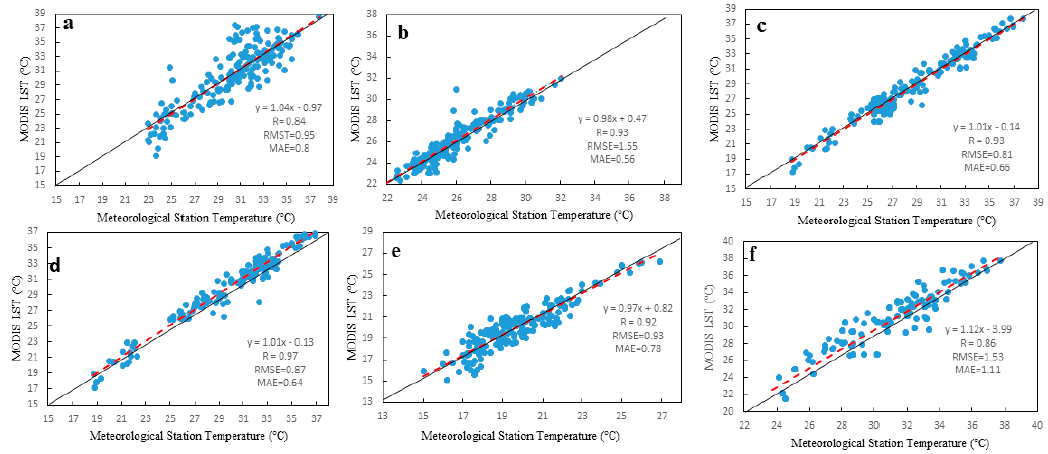
Figure 9. Comparison of the monthly data from ground stations in di ff erent countries and the monthly MODIS LST data (( a ) Sudan, ( b ) Algeria, ( c ) Mauritania, ( d ) Ethiopia, ( e ) Congo, and ( f ) South